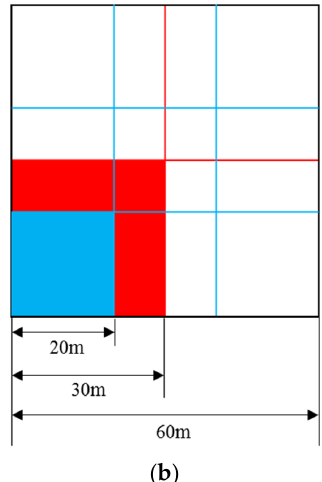
Figure 1. ( a ) Study area, located in the Kuala Belalong Field Studies Centre (KBFSC; 04°32 ′ 50.1 ″ N, 115°09 ′ 29.6 ″ E) in the Ulu Temburong National Park, Brunei Darussalam; ( b ) Subdivisions of 20 m × 20 m plots and 30 m × 30 m plots. 2.2. Field Above ‐ Ground Biomass (AGB) Estimates